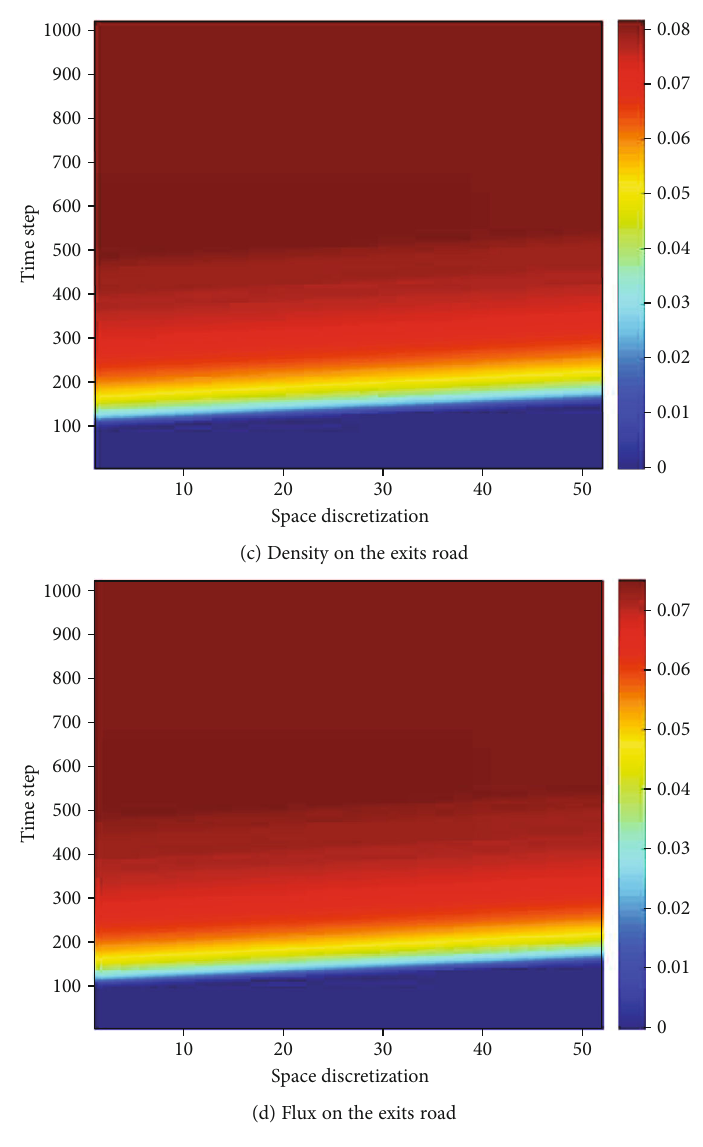
Figure 8: Density and fl ux pro fi les between the merging and diverging main lane of the roundabout under consideration and on the existing roads. In the case (a), shocks are produced on roads S (c). Corresponding tra ffi c fl uxes are shown in (b) and (d),